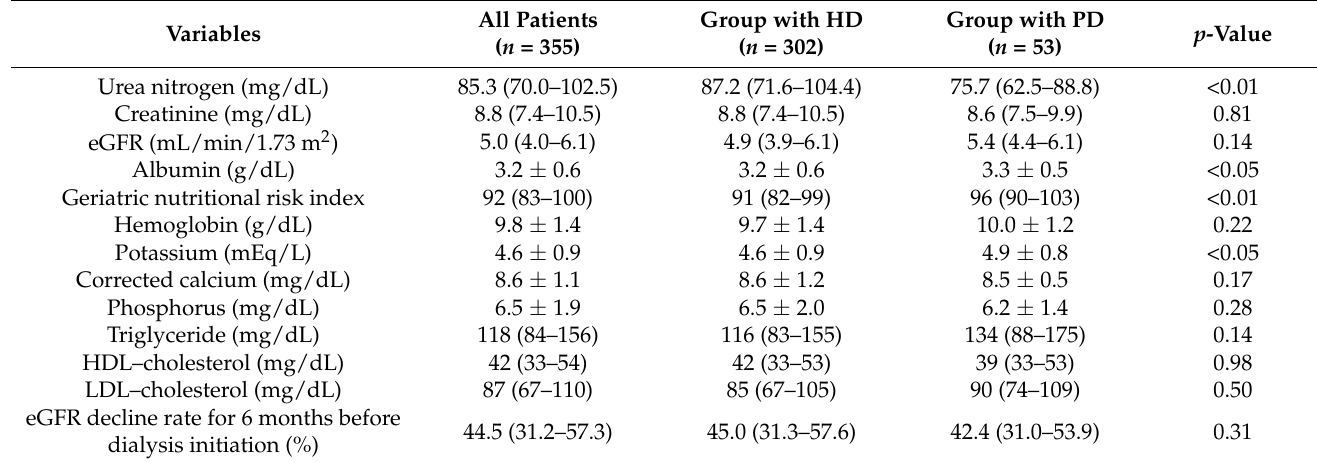
Table 2. Biochemical data of groups with patients with HD and PD at dialysis initiation.